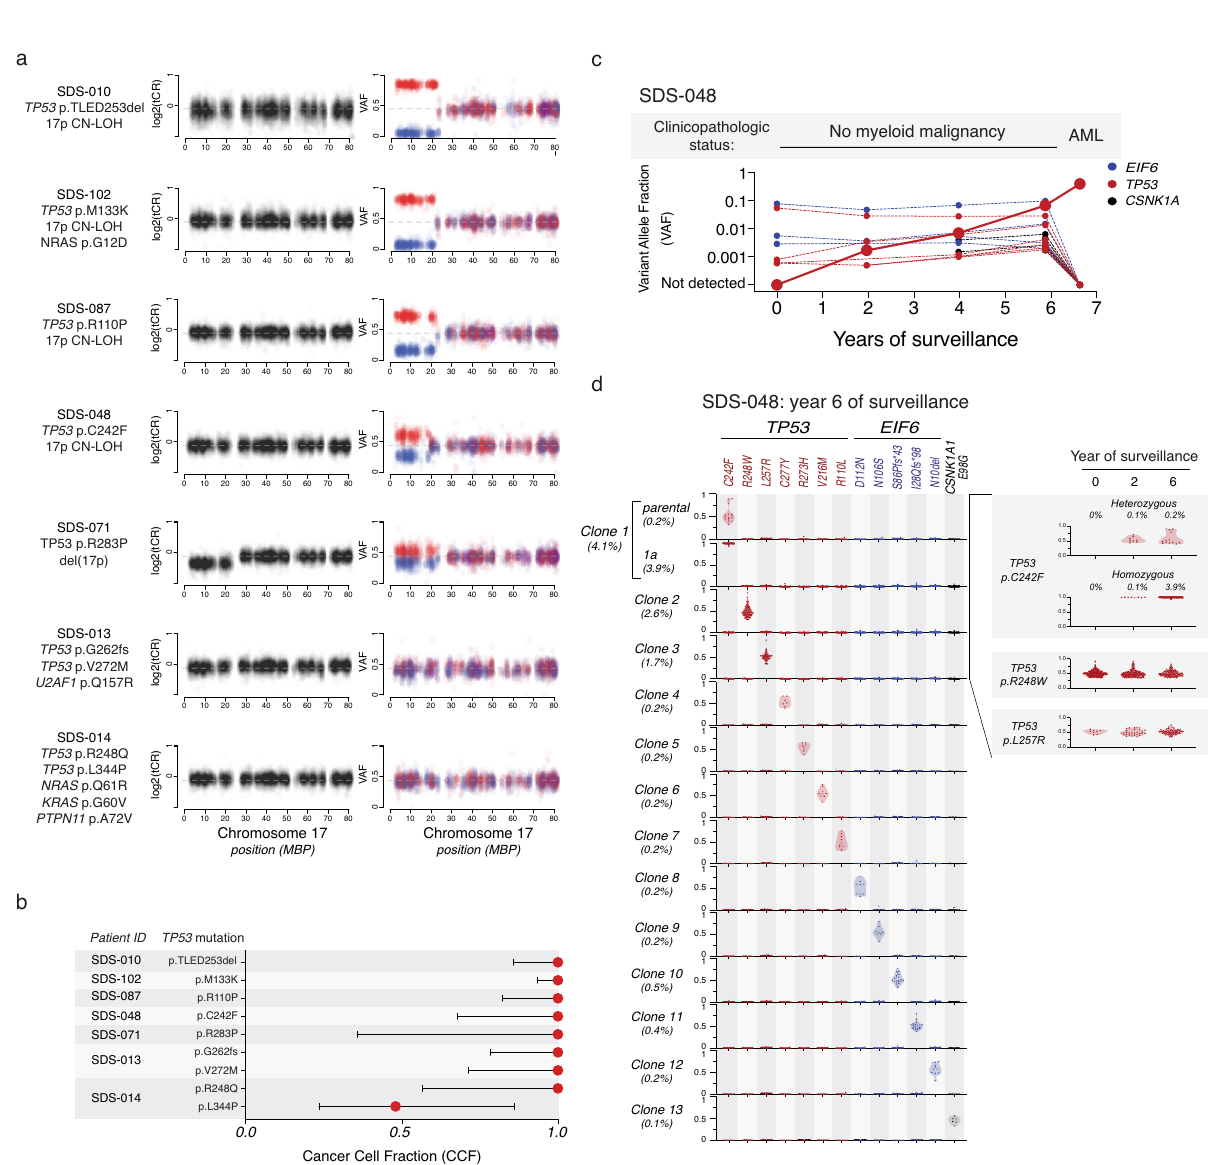
Fig. 5 CH in SDS patients. a Frequency of mutations in the indicated genes among the 58 SDS patients with CH. b VAFs in the indicated genes among 378 samples from SDS patients with clonal hematopoiesis. Horizontal lines within boxes indicate median VAF. Boxes center around the median and span the 25th and 75th percentiles with whiskers and outliers de fi ned by the Tukey method. c Proportion of patients in the study cohort per decade of age with detectable CH, where CH was de fi ned as the presence of a recurrent somatic clonal genetic alteration. d , e Shown is the VAF of each somatic EIF6 (blue), TP53 (red) or CSNK1A mutation (black) from d six patients who developed clonal hematopoiesis in the fi rst decade of life and e six patients who were found to have clonal hematopoiesis in their second or third decade of life. Arrows indicate timing of sample acquisition. Points represent the VAF for detected mutations f , Fold change in VAF of all somatic EIF6 (blue) and TP53 (red) mutations from time of fi rst detection to time of most recent detection in 23 patients with CH. Boxes center around the median and span 25th and 75th percentiles with whiskers and outliers de fi ned by the Tukey method. g Ages of patients at diagnosis of six patients with severe bone marrow failure (BMF), 15 patients with myeloid neoplasm (MN), or no BMF/MDS with (59 patients) or without CH (19 patients) at last follow up. Boxes center around the median and span the 25th and 75th percentiles, whiskers extend to the 10th and 90th percentiles.